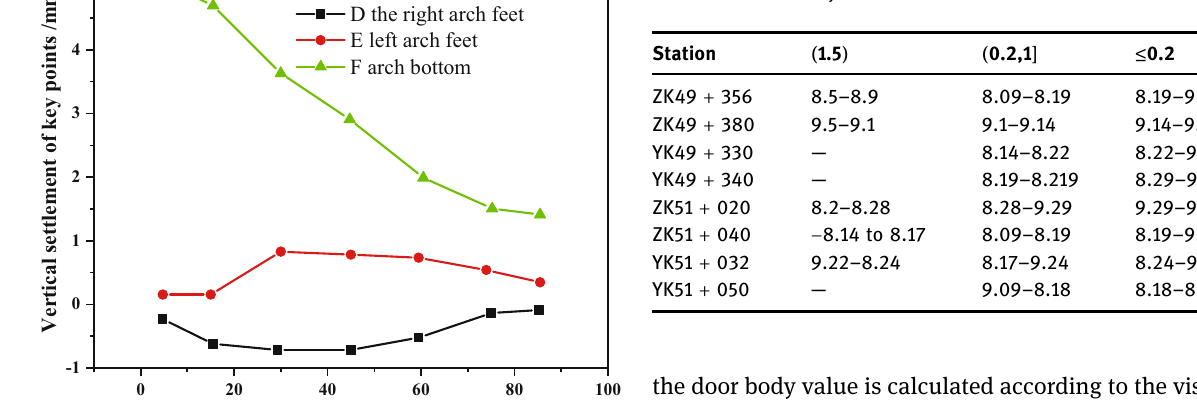
Table 2: The distribution range of the convergence displacement